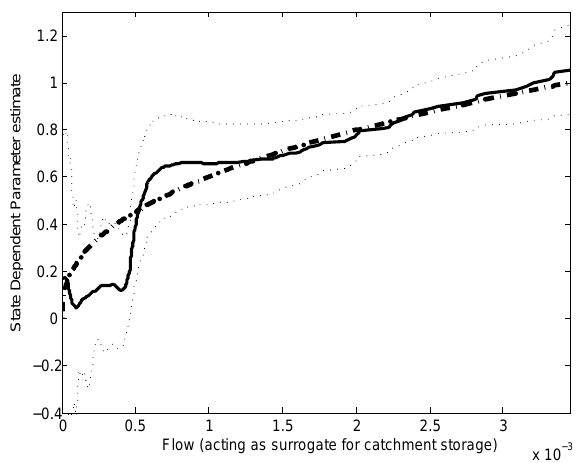
Fig. 1. This graph shows the estimated non-parametric SDP rela- tionship (full line) between measured flow and the effective rainfall parameter, where the flow is acting as a surrogate for catchment soil moisture. The 95% confidence bands are shown by the dotted lines and the dash-dot line is a parametric estimate of the SDP relation- ship obtained in the later estimation stage of the modelling using a power law approximation.